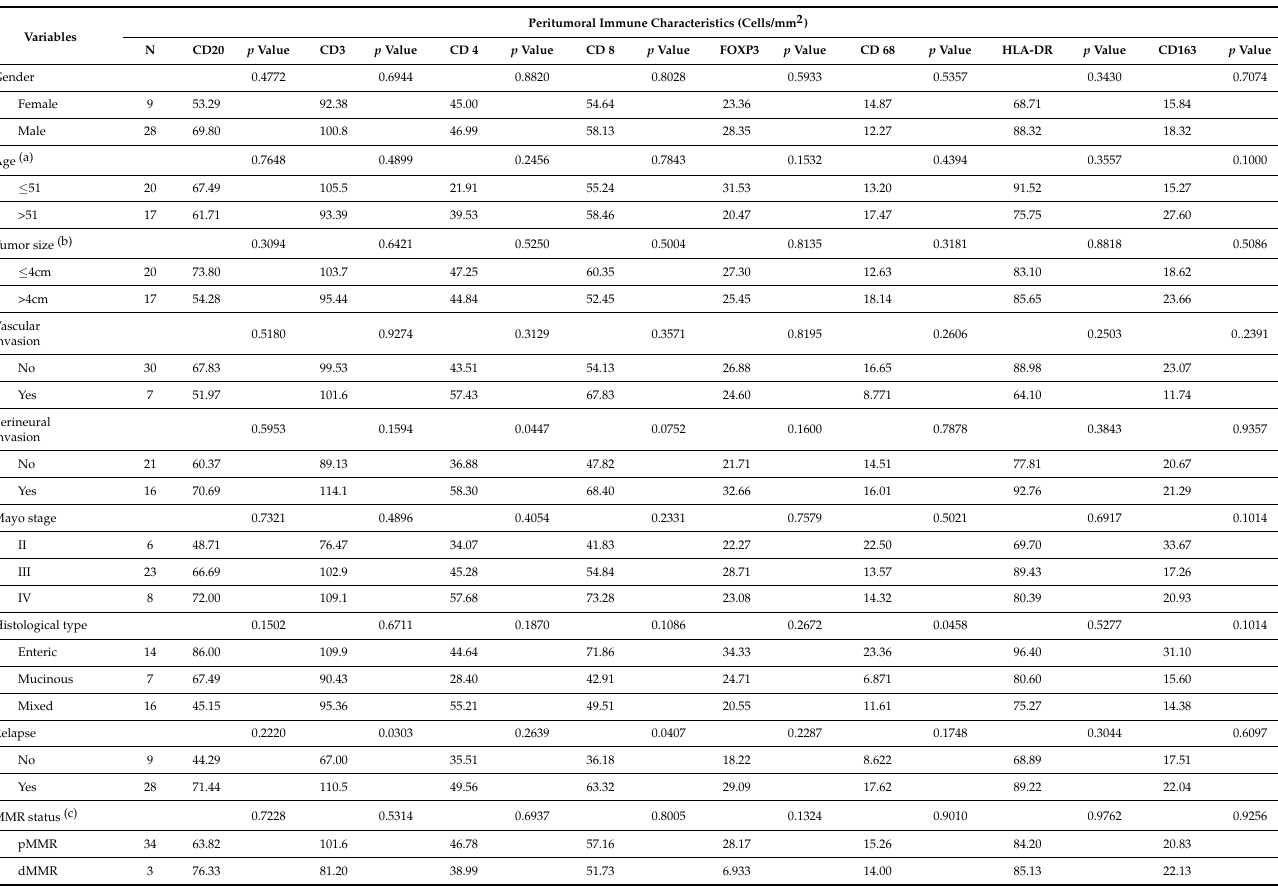
Table 2. Correlation between the peritumoral immune characteristics and clinicopathological vari- ables in UrC